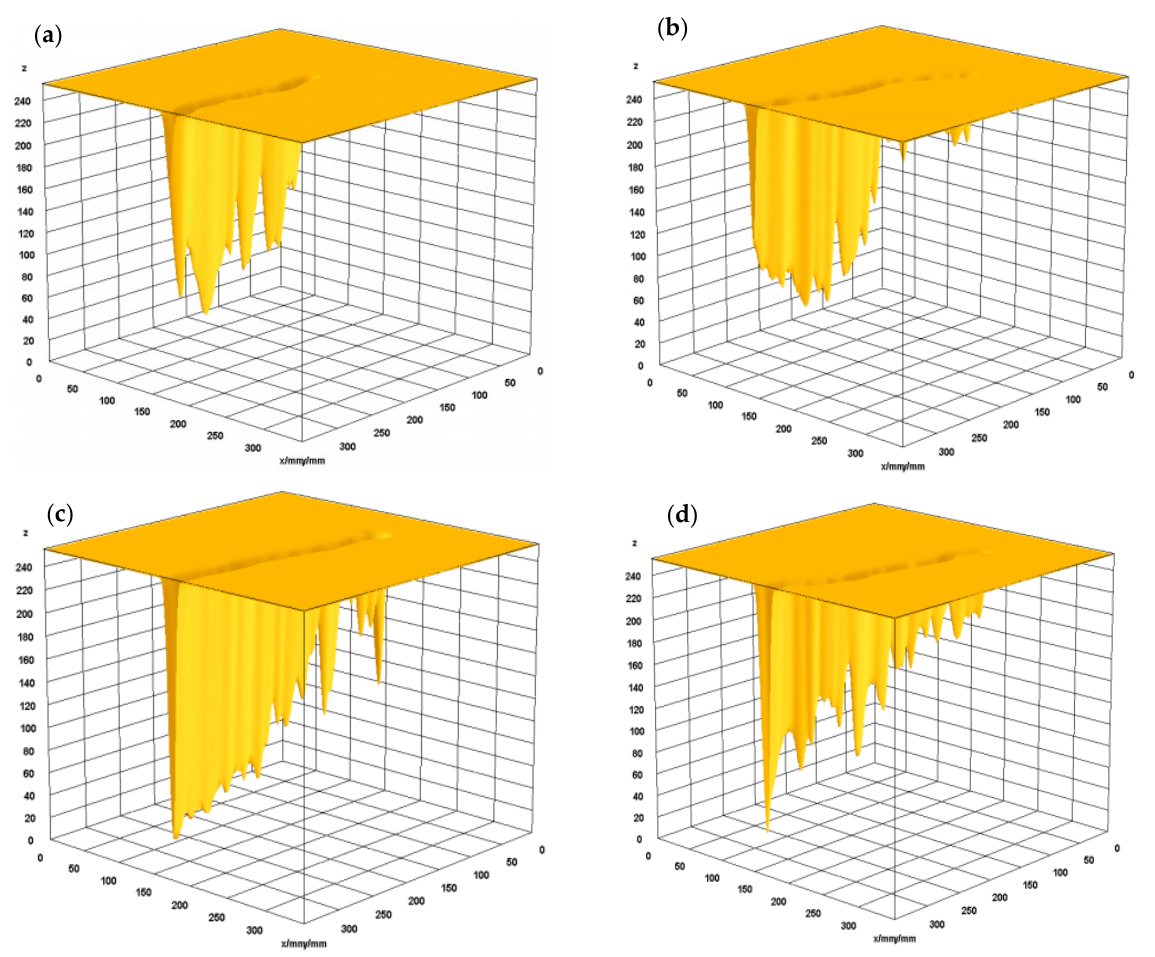
Figure 14. 3D surface graphs of the fracture surfaces of the ( a ) 0 NCa, ( b ) 0.5 NCa, ( c ) 1 NCa, and ( d ) 1.5 NCa samples.